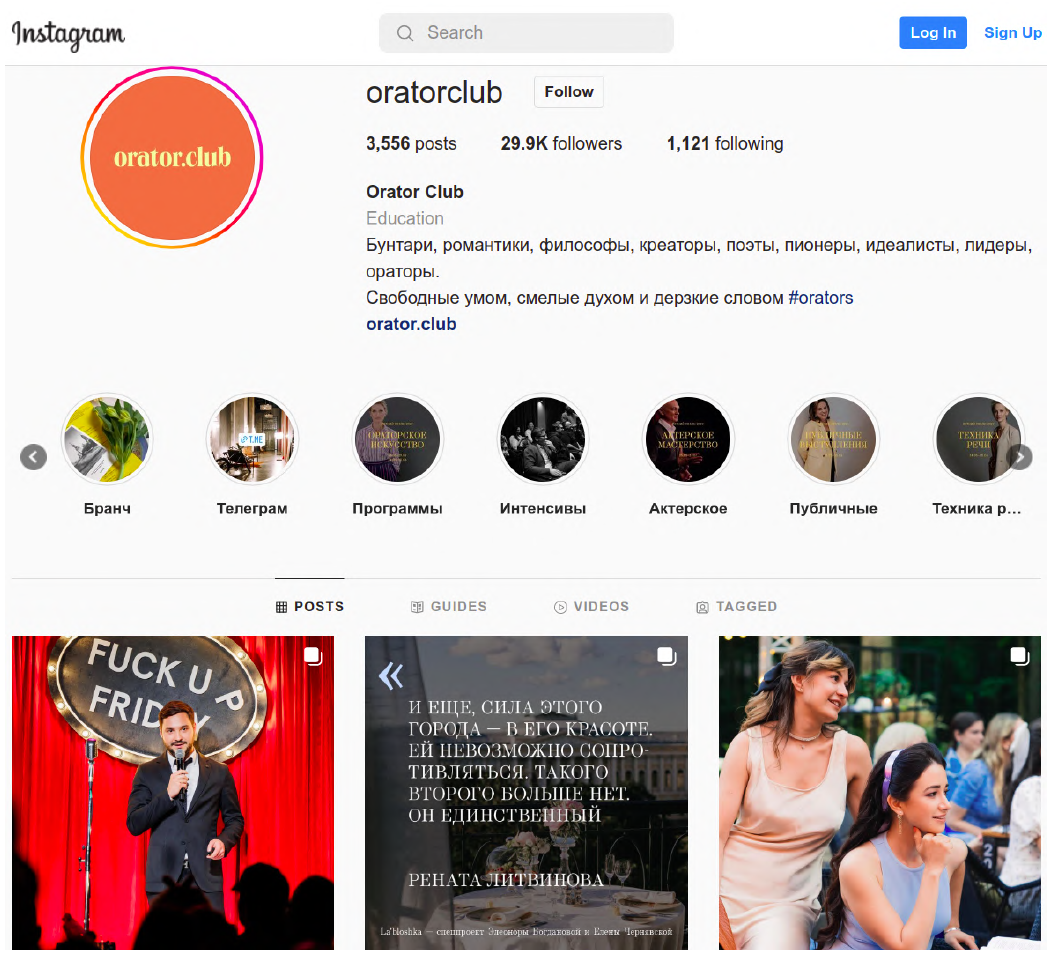
Figure 10: “Orator Club Community” on Instagram.